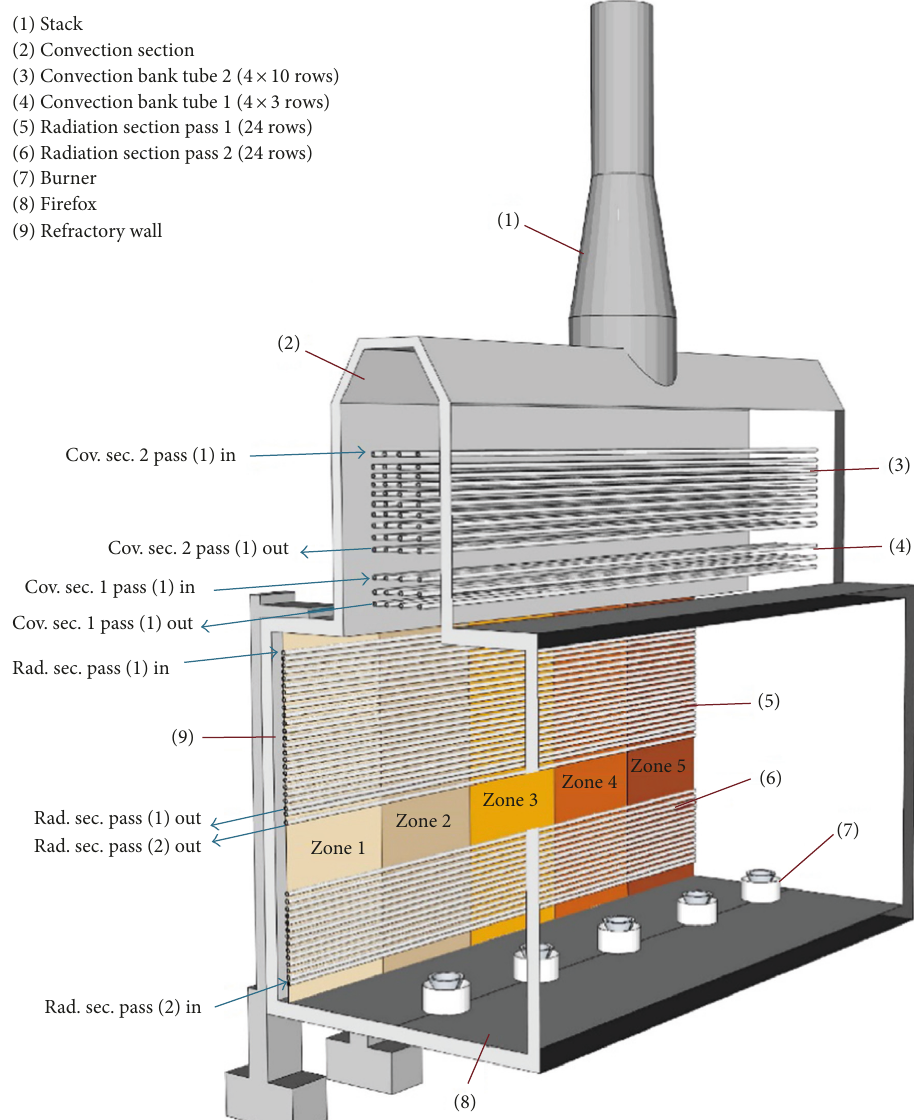
Figure 1: Schematic of the fired-heater